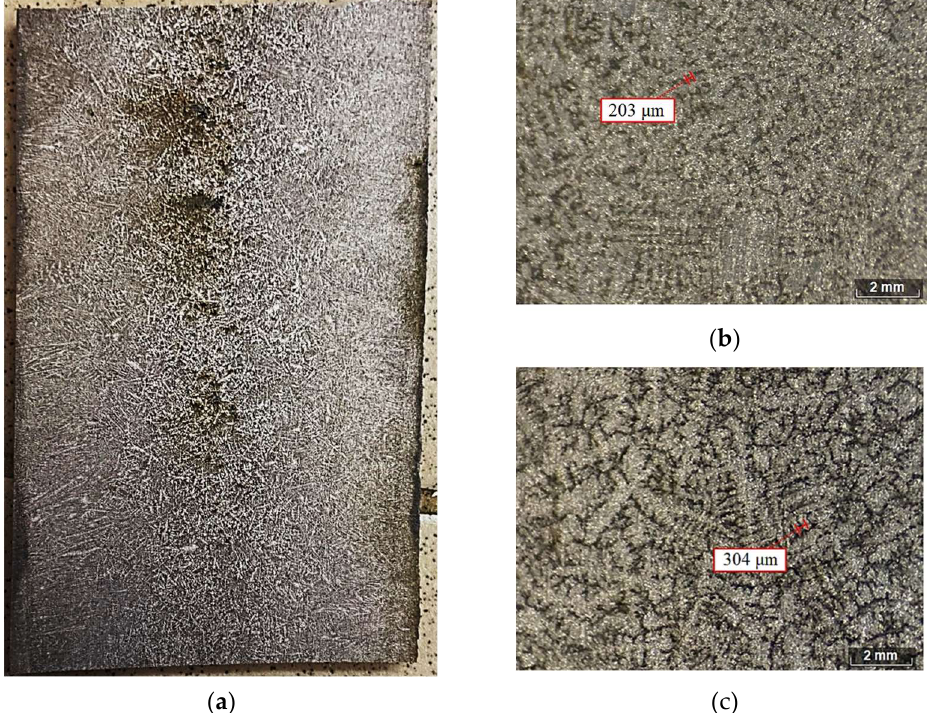
Figure 5. Macrostructure of 0.4C-Cr + Bi + S steel ingot. Full profile longitudinal template ( a ); columnar ( b ) and misoriented and equiaxed ( c ) crystals. Ingot ( a ) diameter is 90 mm on top and 80 mm on bottom.